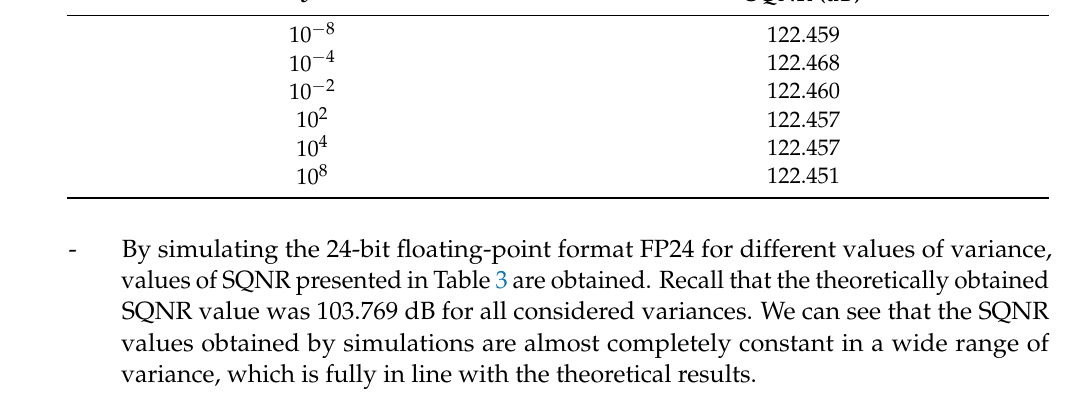
Table 2. Values of SQNR (dB) obtained by simulation of the adaptive 24-bit fixed-point format with n = 5 based on the double adaptation described in Section 4.2, for different values of variance σ 2 . σ 2